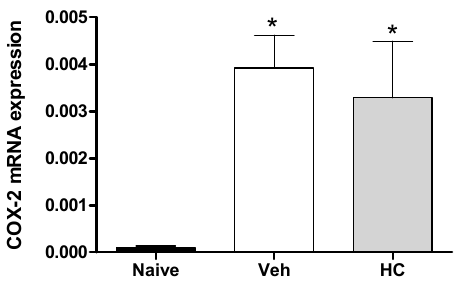
Figure 4. Effect of treatment with hecogenin on COX-2 mRNA paw levels. Mice were injected with hecogenin (HC; 20 mg/kg) or vehicle (Veh; control group) by the intraperitoneal route 30 min before the intraplantar injection of complete Freund’s adjuvant (CFA). The paw levels of COX-2 mRNA were measured by Real Time PCR 2 h after the CFA injection. Data are reported as means ± SEM; n = 6 mice per group. * p < 0.05 vs. naive group, one-way ANOVA followed by Tukey’s